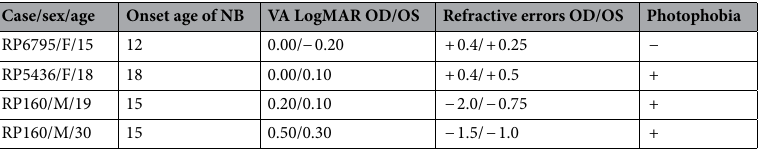
Table 3. Clinical characterization of patients with EYS associated RP in family 501. M male, F female, NB night blindness, VA visual acuity, OD right eye, OS left eye. + sign = present; − sign = not present.